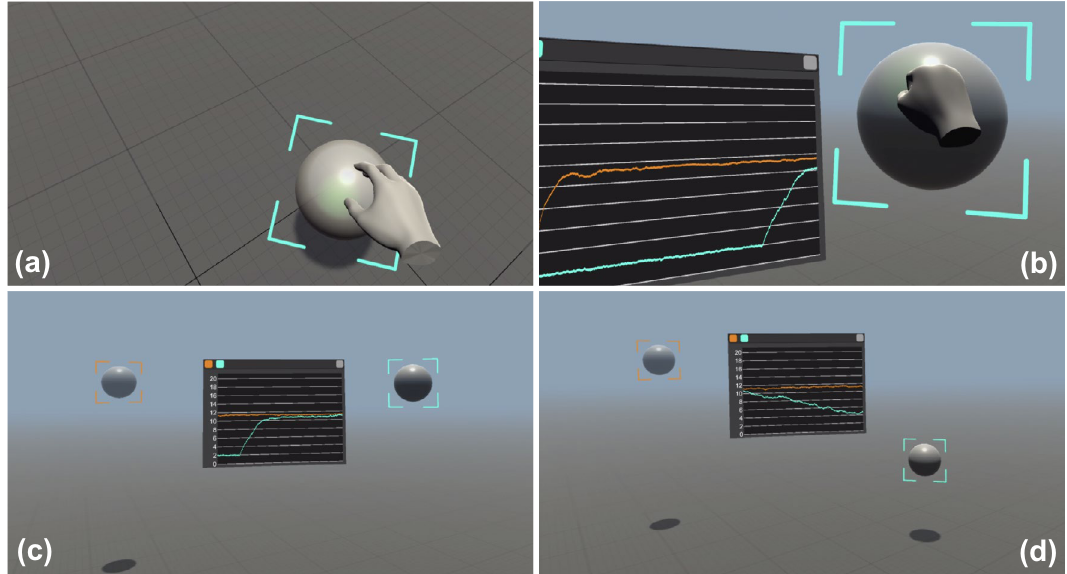
Figure 3. A silica (right) and a polystyrene (left) microspheres, both having a radius of 1 µ m, are grabbed with a virtual hand ( a ), lifted to a height of z = 10 µ m from the coverslip ( b ) and finally released to observe their sedimentation ( c ). The heights of the targeted particles can be monitored in real time on a chart that clearly shows that the right particle is heavier ( d ). See also Supplementary Video 1. This figure was made using Unity 28